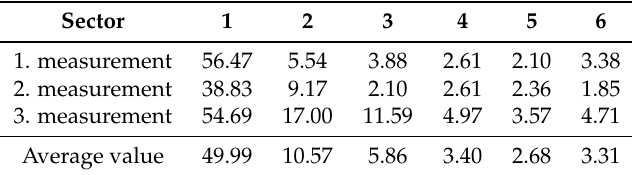
Table 2. Average values of the oil film areal density (in g/m 2 ) in a 25-mm slim pipe. The section length is 1 m. The total measured pipe length is 6 m.